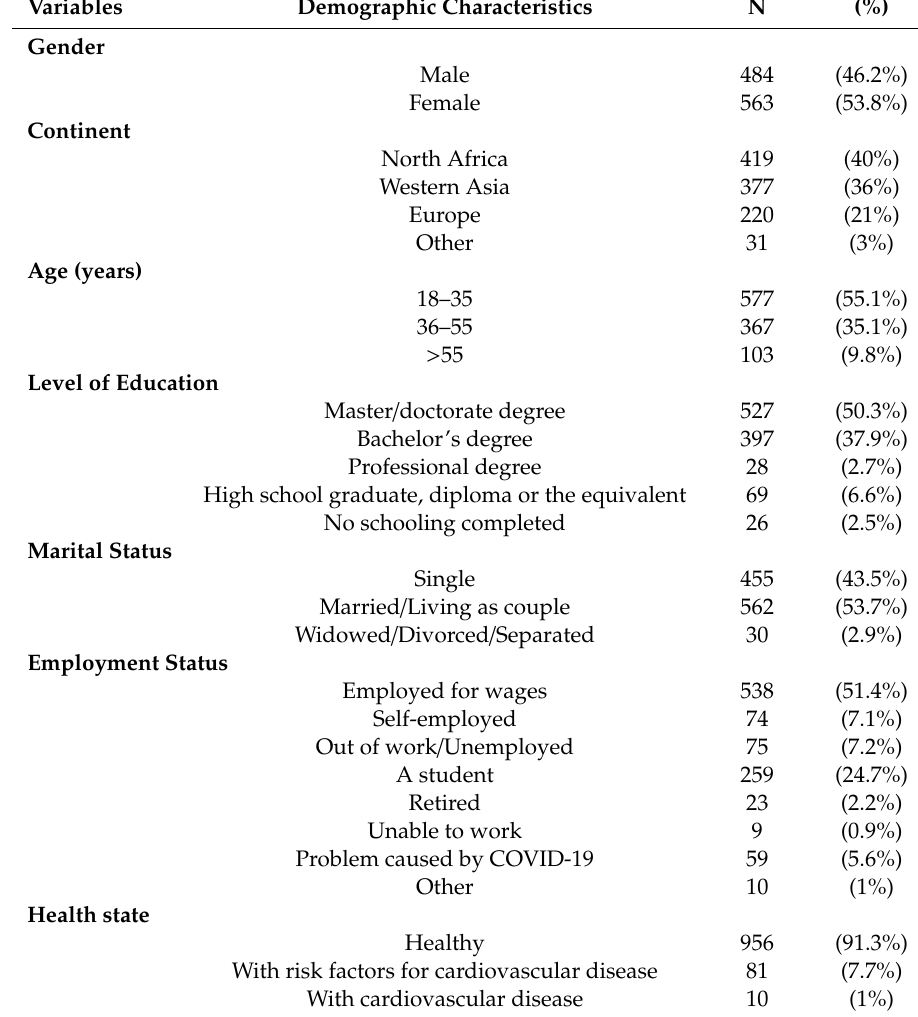
Table 1. Demographic characteristics of the